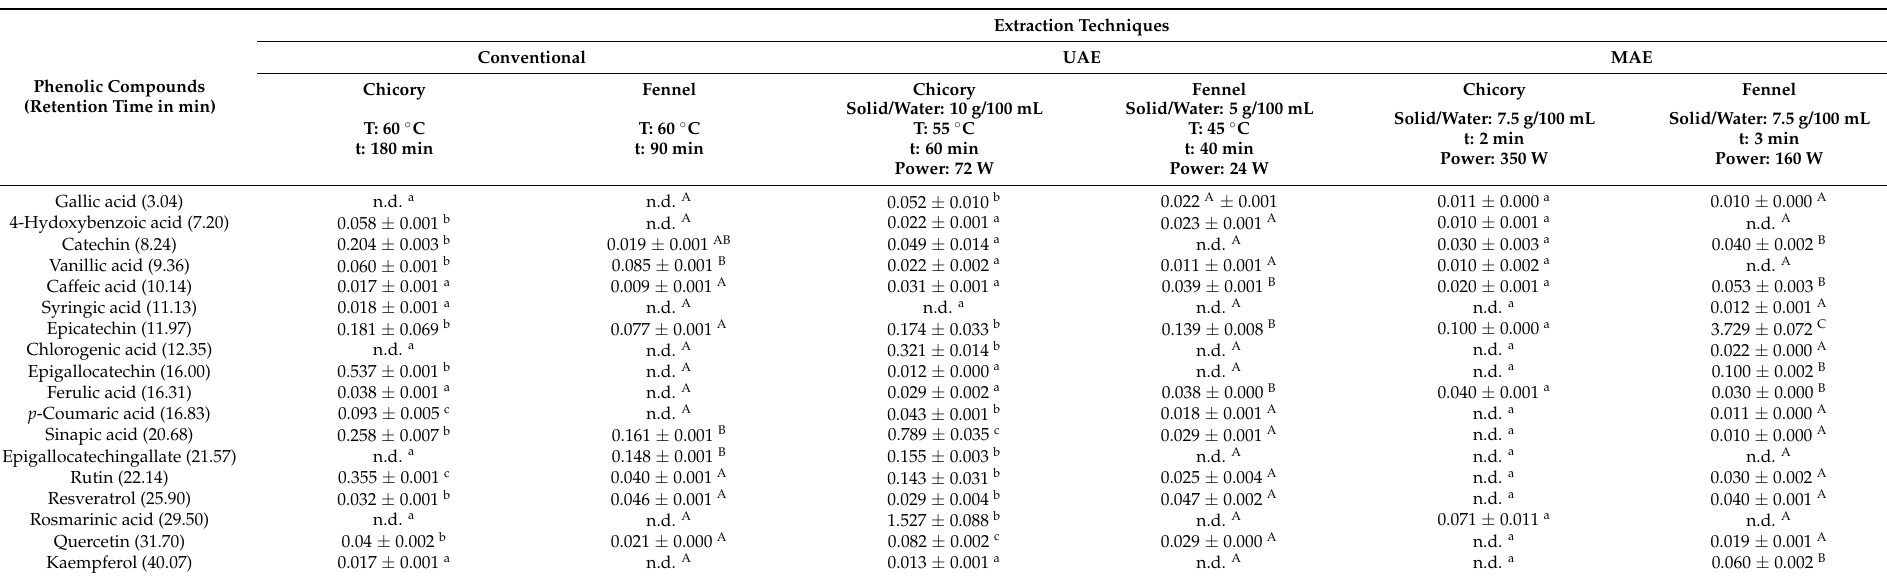
Table 4. The phenolic profiles of the extracts corresponding to the combinations of independent variables able to maximize the total phenolic concentrations. Data are expressed as mg/g